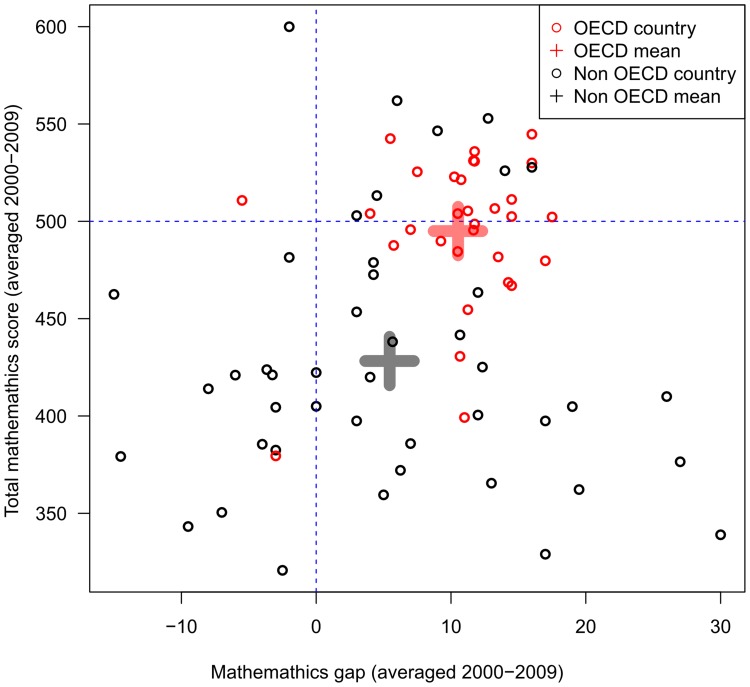
Relation between sex difference in mathematics and overall mathematics score for OECD and non-OECD countries.The mathematics scores have been averaged for the four assessments, which means that some countries’ scores are based on four assessments (e.g., Germany and 32 other countries/regions which participated in all four assessments), and some countries’ scores on only one assessment (e.g., Malta and 15 other countries). Sex difference in mathematics equals boys’ mean score - girls’ mean score. The OECD countries not only have higher overall scores, their mathematics gap, favoring boys, is more tightly clustered between −5.5 and 17.5 points (M = 10.5,SD = 5.1). The two outliers are Iceland (HDI rank = 2, GGGI rank = 1) and Georgia (HDI rank = 61, GGGI rank = 40). In contrast, there is considerable variability in the non-OECD countries (between −15.0 and 30.0 points, M = 5.4, SD = 10.5), with boys’ having higher mathematics achievement in some of them (e.g., Costa Rica) and girls having higher mathematics achievement in others (e.g., Albania). The same analyses applied to the 4 individual PISA assessments show the same pattern.